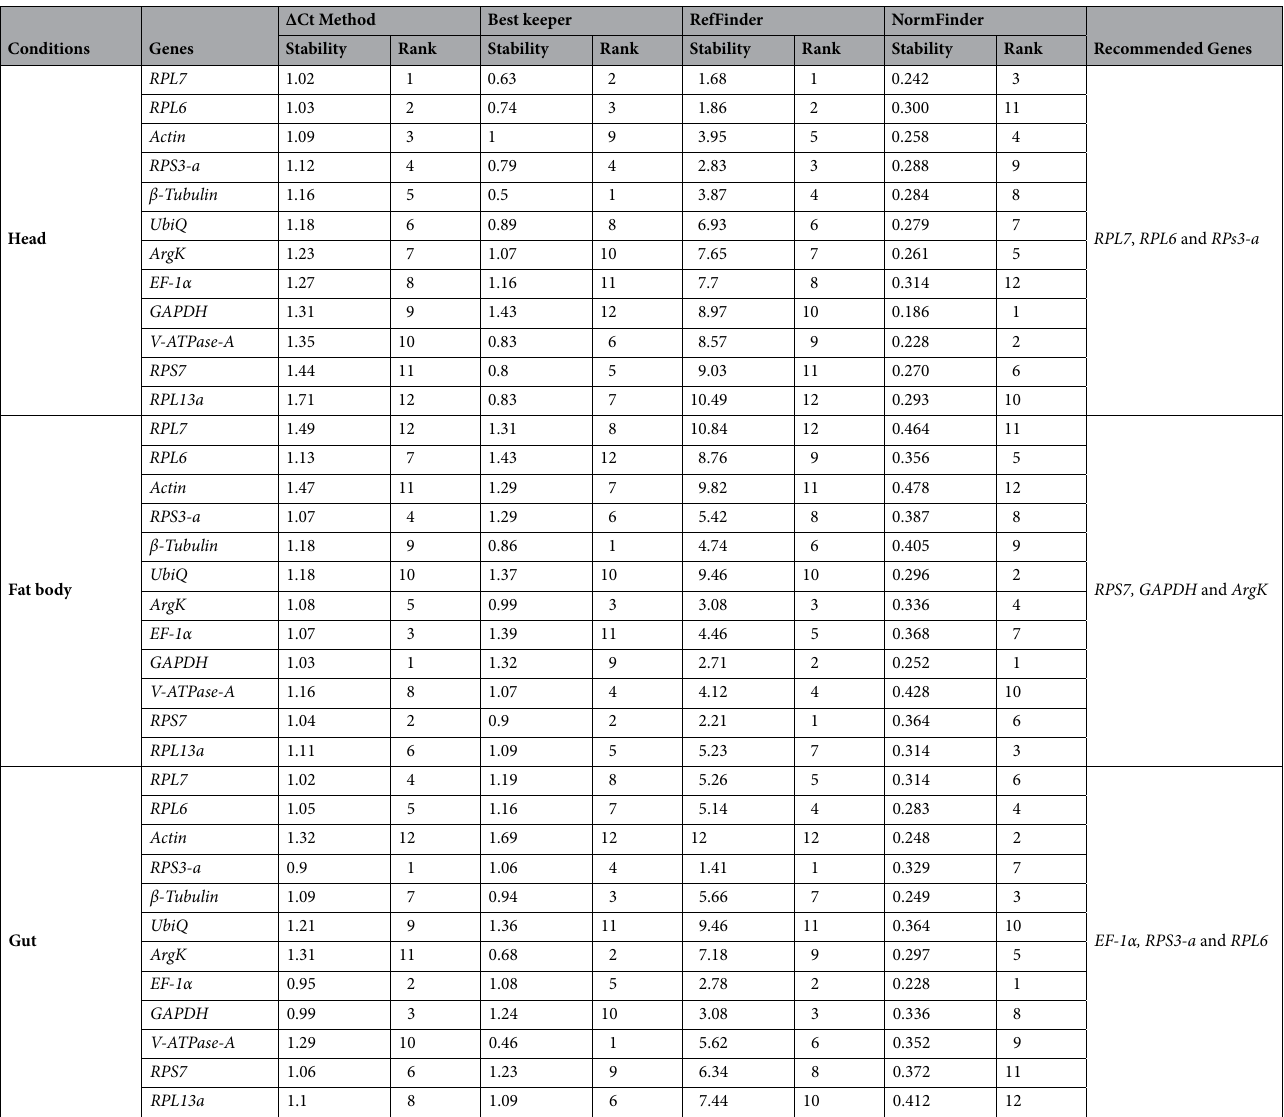
Table 4. Ranking of the candidate reference genes based on stability values performed by Delta Ct, BestKeeper, RefFinder, and NormFinder in tissue-specific